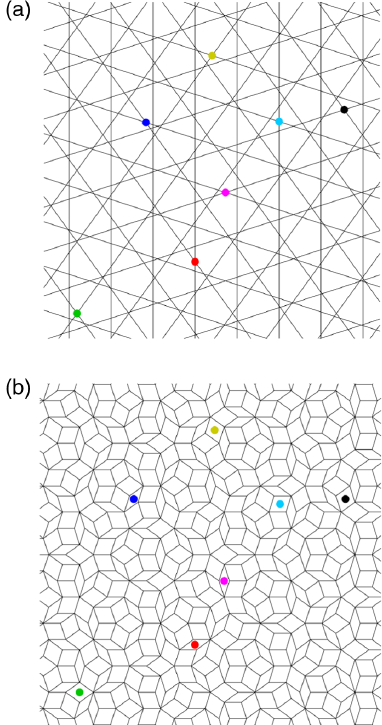
FIG. 2. Duality between a 5-grid (a) and the Penrose tiling it generates (b) through the GDM. A few nodes in the 5-grid and their corresponding parallelograms in the Penrose tiling are marked by dots of the same